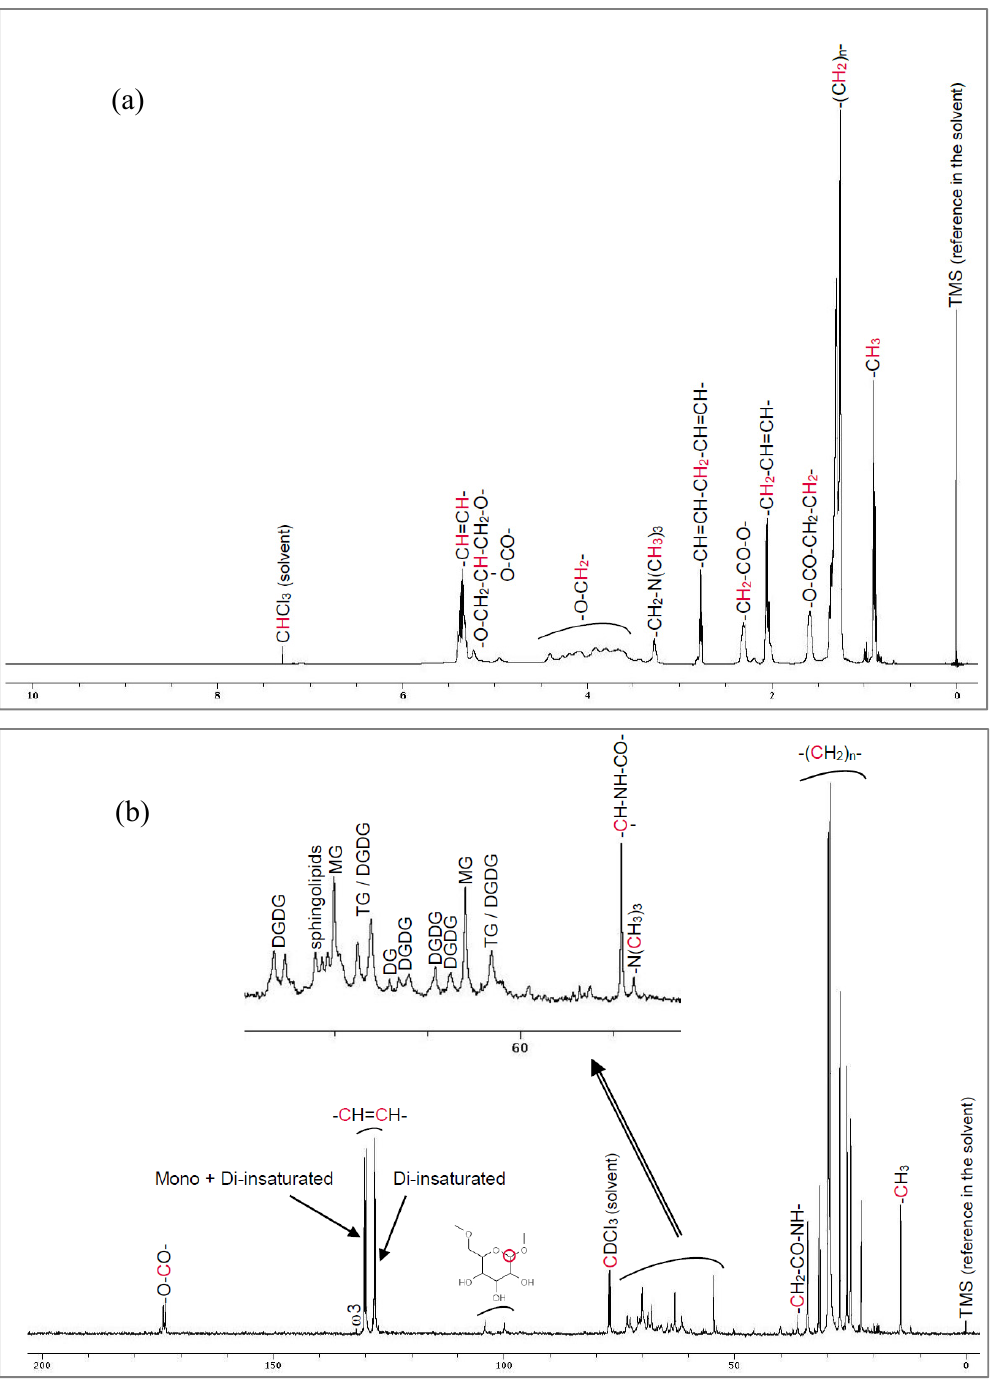
Figure 1. High field NMR spectra of WPLC; ( a ) 1 H-NMR spectra and ( b ) 13 C-NMR (TG: Triglycerides, DG: Diglycerides, MG: